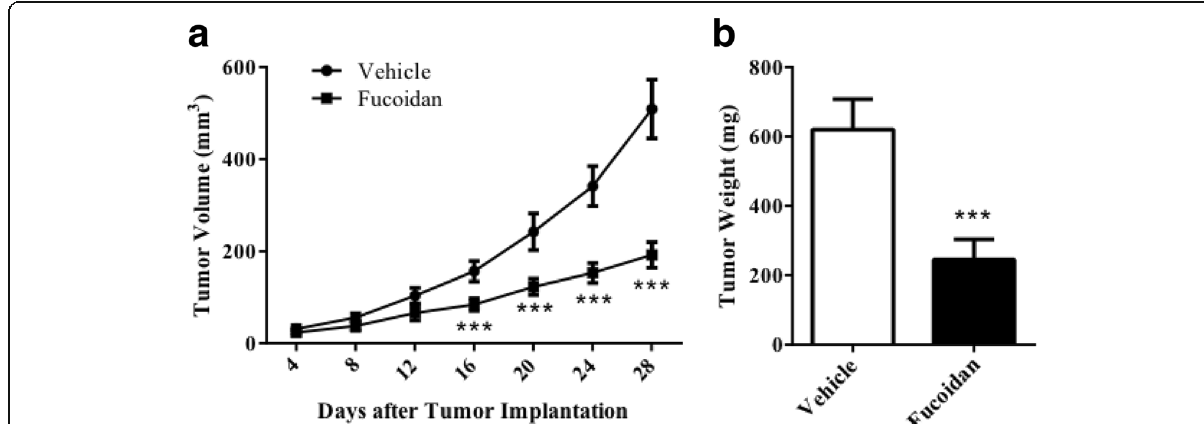
Fig. 3 Fucoidan inhibited tumor growth of prostate cancer xenograft. Athymic nude mice were injected subcutaneously with DU-145 cells (1 × 10 7 cells in 0.2 mL PBS), and treated with vehicle (saline) or fucoidan (20 mg/kg) by oral gavage for 28 days. a Tumor volume. b Tumor weight. *** P < 0.001 vs. vehicle group. N = 6 for each group